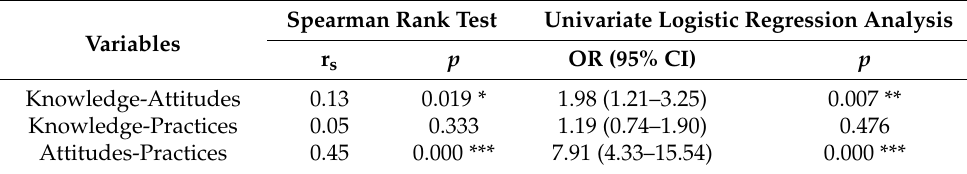
Table 2. Relationship between knowledge, attitudes, and practices ( n = 350).